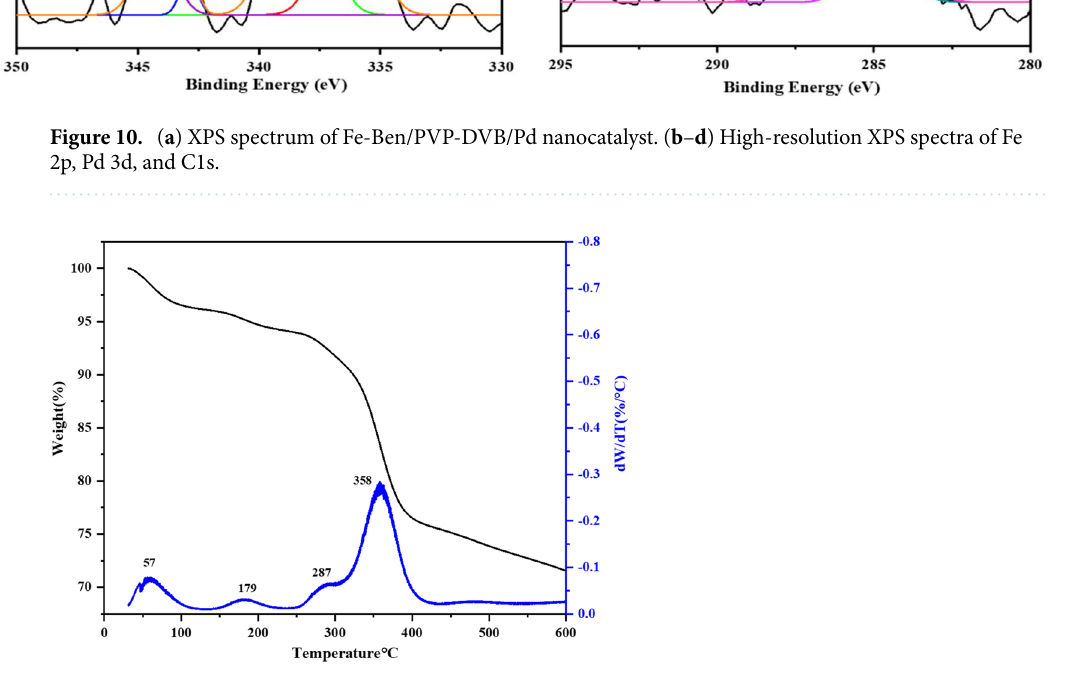
Figure11. TGA and DTG thermograms of Fe-Ben/PVP-DVB/Pd nanocatalyst at a heating rate of 10